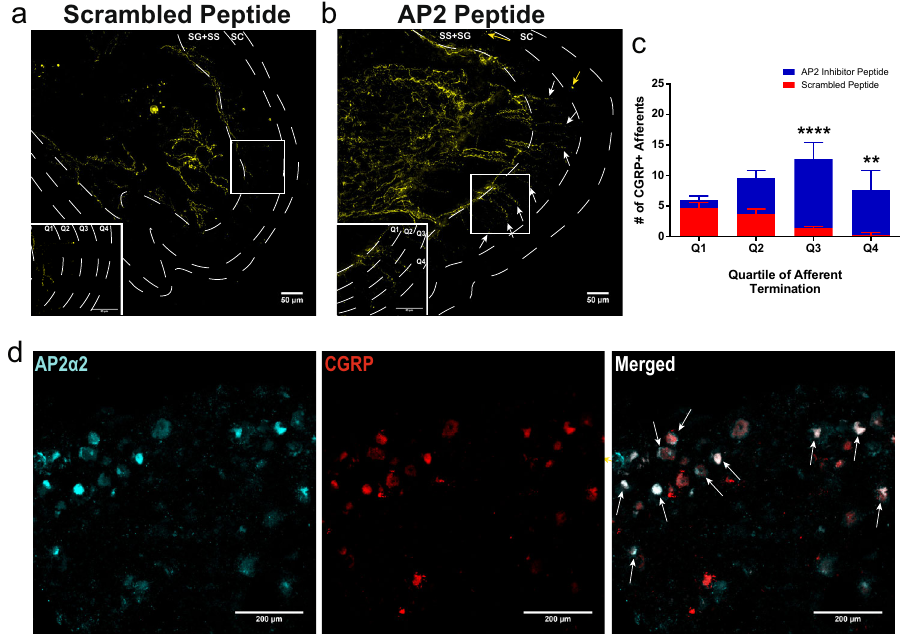
Fig. 6 Local inhibition of endocytosis in peripheral nociceptors potentiated CGRP immunoreactivity in the super fi cial layers of the dermis and Ap2 α 2 is differentially distributed in CGRP + human DRG neurons. a Representative image showing CGRP immunoreactivity in an unin fl amed hind paw injected with the scrambled peptide. Typically, CGRP immunoreactivity terminates in the proximal stratum granulosum (SG). b Representative image showing CGRP immunoreactivity in an unin fl amed hind paw injected with the AP2 inhibitor peptide. White arrows : peripheral nerve fi bers exhibited robust CGRP immunoreactivity in the very distal layers of the SG and some CGRP immunoreactive fi bers could be seen in very super fi cial stratum corneum (SC) layer. Yellow arrows ; peripheral nerve fi bers displaying CGRP immunoreactivity in super fi cial layers of the SC. (Inserts) Magni fi ed sections illustrating SG quadrants. c Quanti fi cation of CGRP + afferent termination in each SG quadrant (Q1, Q2, Q3, and Q4; n = 3). Signi fi cance was determined using a multiple t-test using Holms-Sidak correction with p < 0.05; * p < 0.01;** p < 0.005;*** p < 0.001;****. Quartile 3 p -value = 0.0004. Quartile 4 p -value = 0.0076. Data is presented as mean ± S.E.M. d Representative immuno fl uorescent image showing expression patterns of AP2 α 2 (left) and CGRP (middle) in hDRGs. AP2 α 2 is differential expressed in CGRP + DRG neurons. Arrows highlight strong co-localization of CGRP and AP2 α 2. SG Stratum Granulosum, SS Stratum Spinosum, SC Stratum